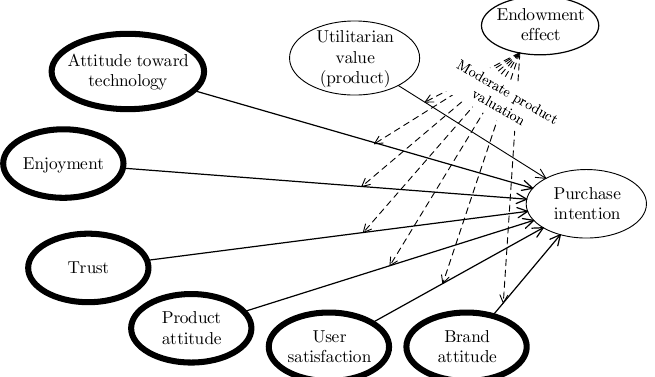
Figure 3. The unified conceptual framework of consumers’ purchase intention in virtual commerce.